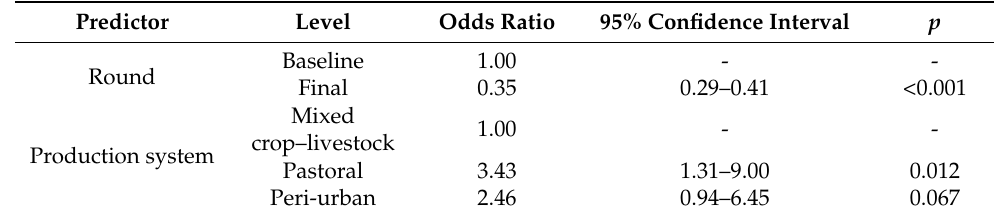
Table 14. Calf mortality model predictions.